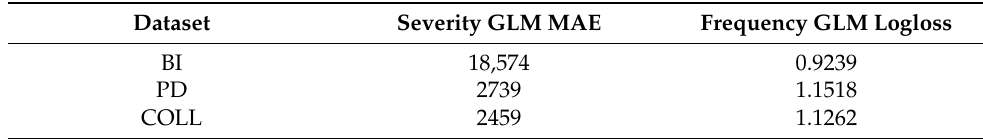
Table 13. GLM validation data metrics for all three datasets.